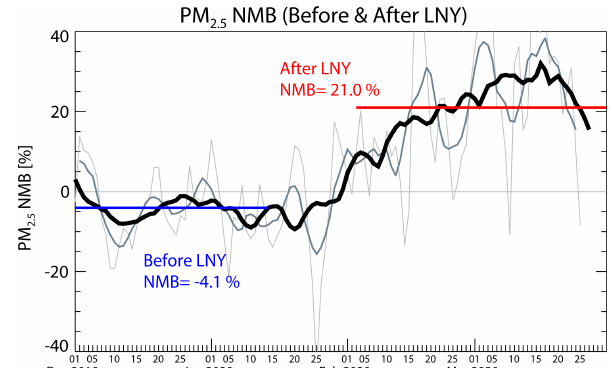
Figure 5. Time series of surface PM 2 . 5 normalized mean bias dur- ing the pandemic period between observed and modeled data with adjusted emissions (i.e., SO 2 and NO x emissions adjusted). Mean NMBs before and after LNY are also marked. Raw, 7d, and 14d moving average NMBs are shown in thin, medium-thin, and thick lines,